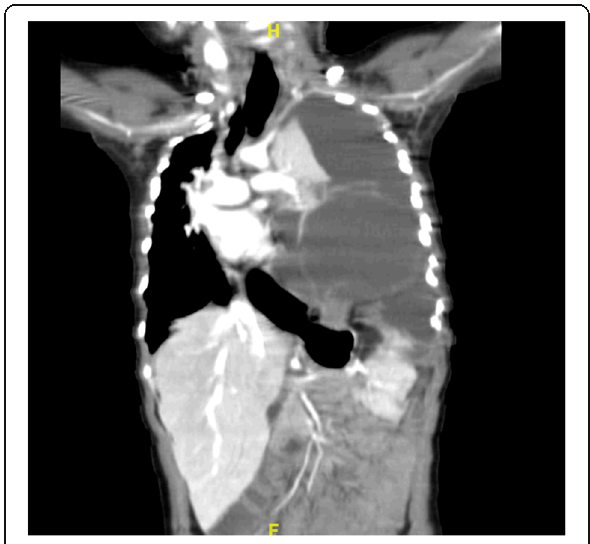
Fig. 2 CECT thorax showing collapsed left lung with non-enhancing wall of the stomach in the left